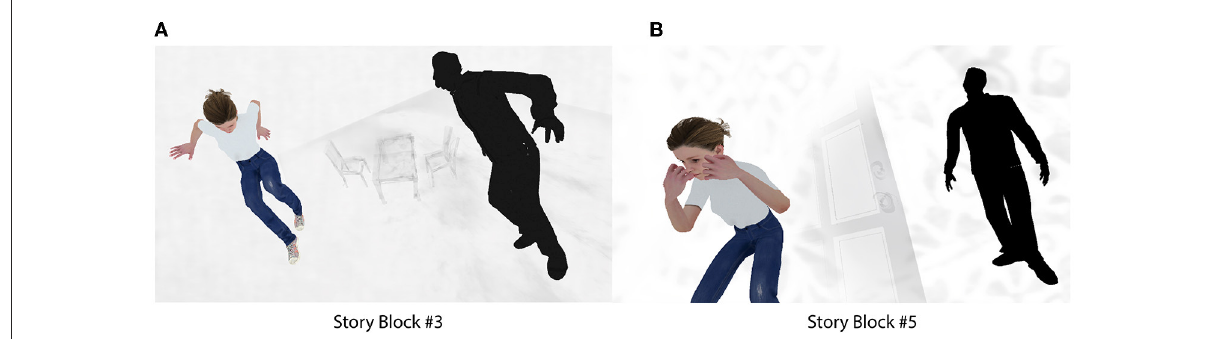
FIGURE3 Spatio-temporal discontinuity in our story environment. (A) Story block #3, (B) Story block #5.